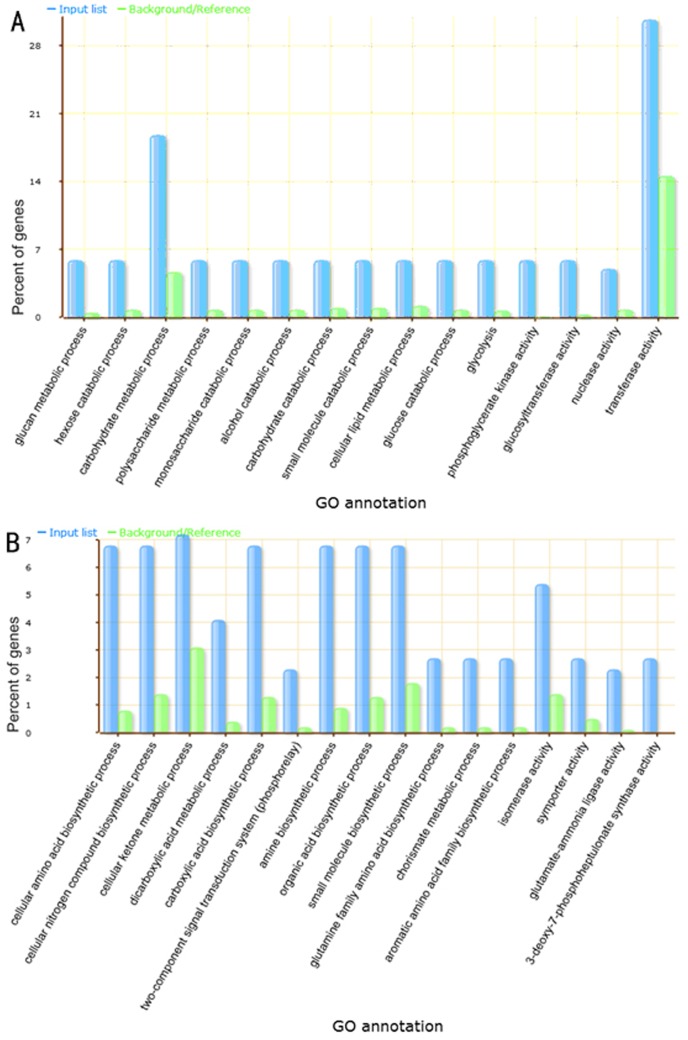
Gene ontology classification of novel miRNA targets in dry seed and imbibed seed.A represents in dry seed, B represents in imbibed seed. The X-axis is the categories of target genes. The Y-axis is the percentage of genes mapped by the categories, and represents the abundance of the GO categaries. AgriGO web-based tool was used to analyze GO categories of genes showing changes in transcription levels.